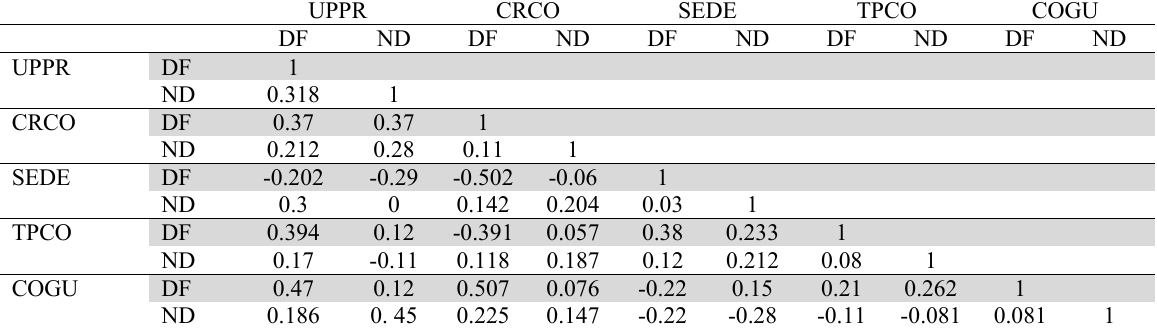
Correlation Matrix of Variables